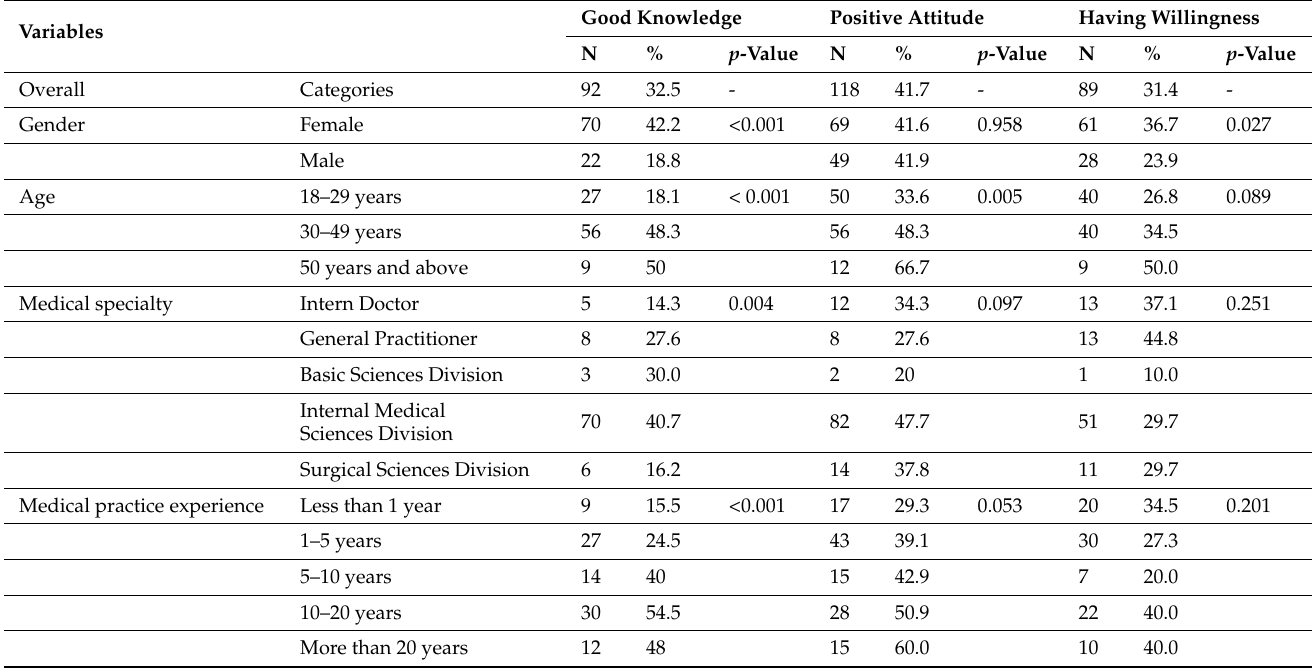
Table 4. Chi-square (x2) test of baseline characteristics of physicians who have good knowledge, positive attitude, and willingness of getting monkeypox